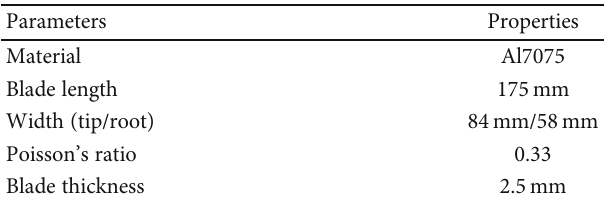
Table 1: Test rig parameters.